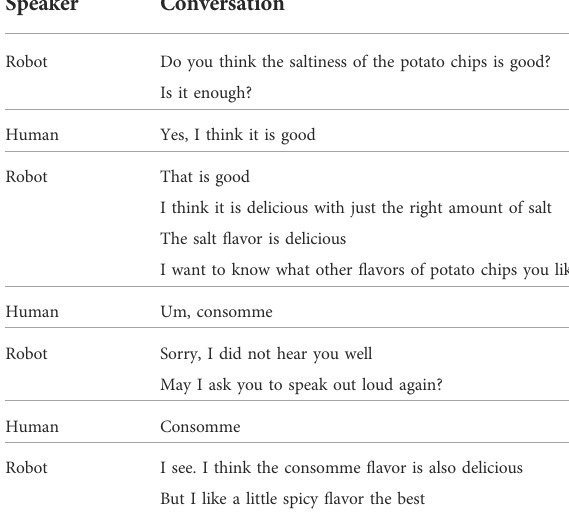
TABLE 3 Example of the conversation during experiment